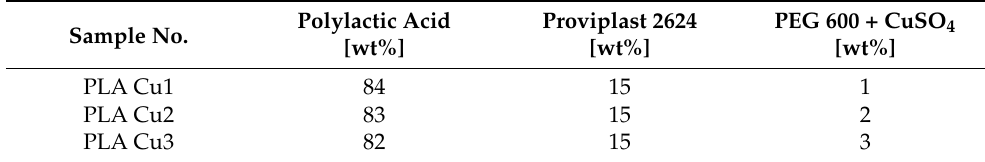
Table 1. The composition of the samples and the obtaining